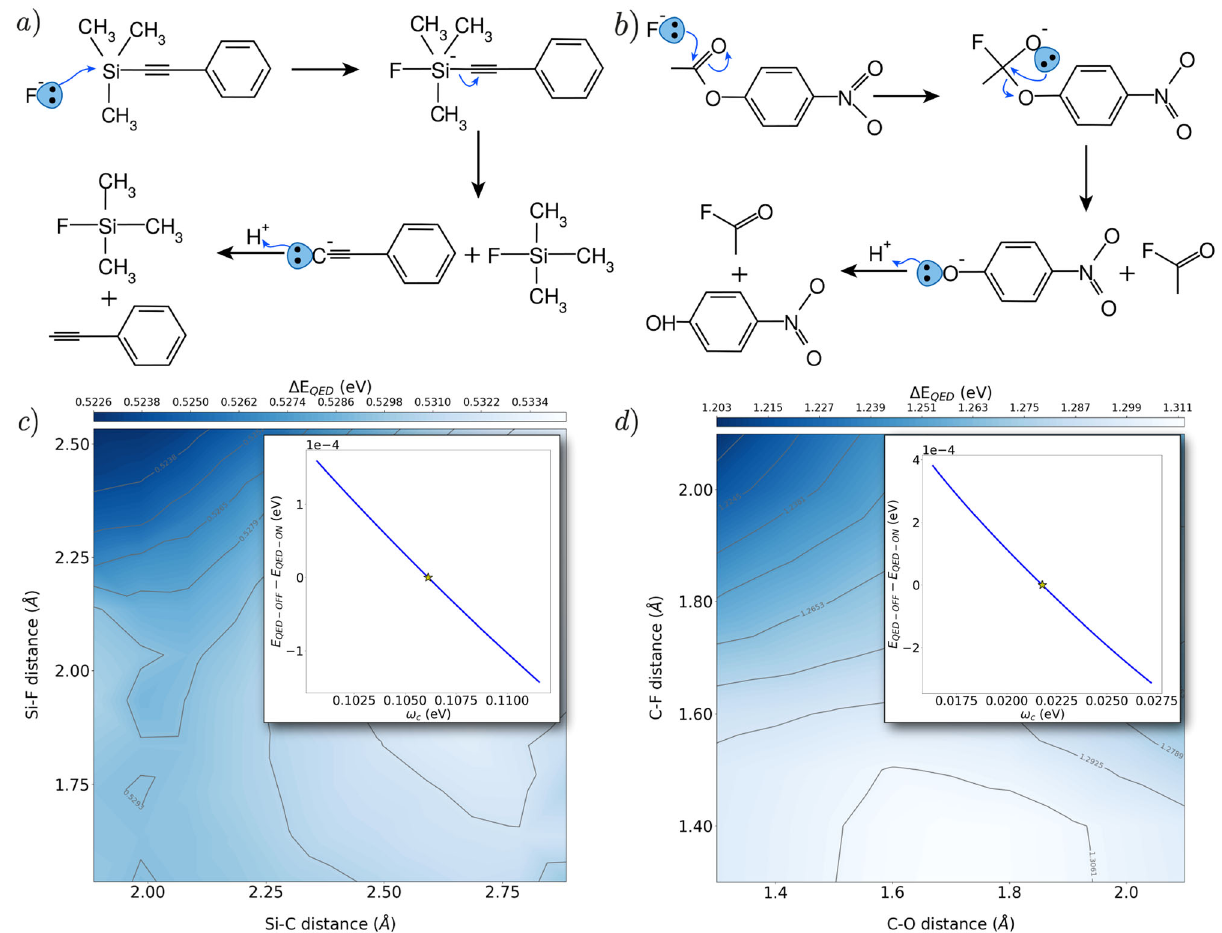
Fig. 3 Potential energy surfaces for reactions in the VSC regime. Schematic representations of the reaction mechanisms for a the deprotection of PTA using TBAF and b the solvolysis of PNPA. The electron movement is represented by blue arrows. c , d Difference between the potential energy surfaces for the PTA deprotection/PNPA solvolysis computed with SC-QED-HF and HF. The dark regions are stabilized by the cavity induced effects while bright regions are destabilized. In the top corners we show that the energy for the PES con fi gurations is monotone with respect to the cavity frequency and therefore no resonance effects are observed. The coupling parameters are λ = 0.025 and λ = 0.044 respectively, while the frequencies are in resonance with the experimental Si – C and the C = O vibrational frequencies. In the insets of panel c and d the resonance features of SC-QED-HF are investigated. The yellow star indicates the resonant frequency. The QED effects have been shifted so that at resonance they are equal to